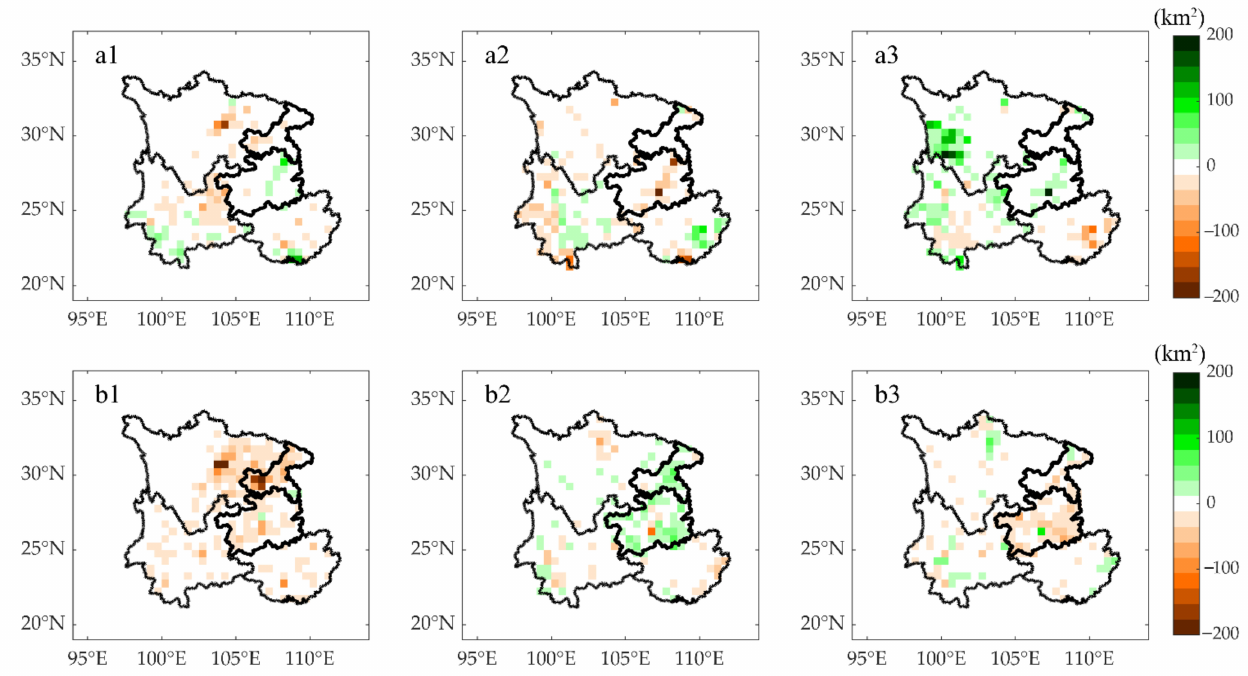
Figure 9. Land-use change in SWC, ( a1 – a3 ) is land use change from 1980 to 2000, ( b1 – b3 ) is land use change from 2000 to 2015. ( a1 , b1 ) are cropland, ( a2 , b2 ) are forest, and ( a3 , b3 ) are